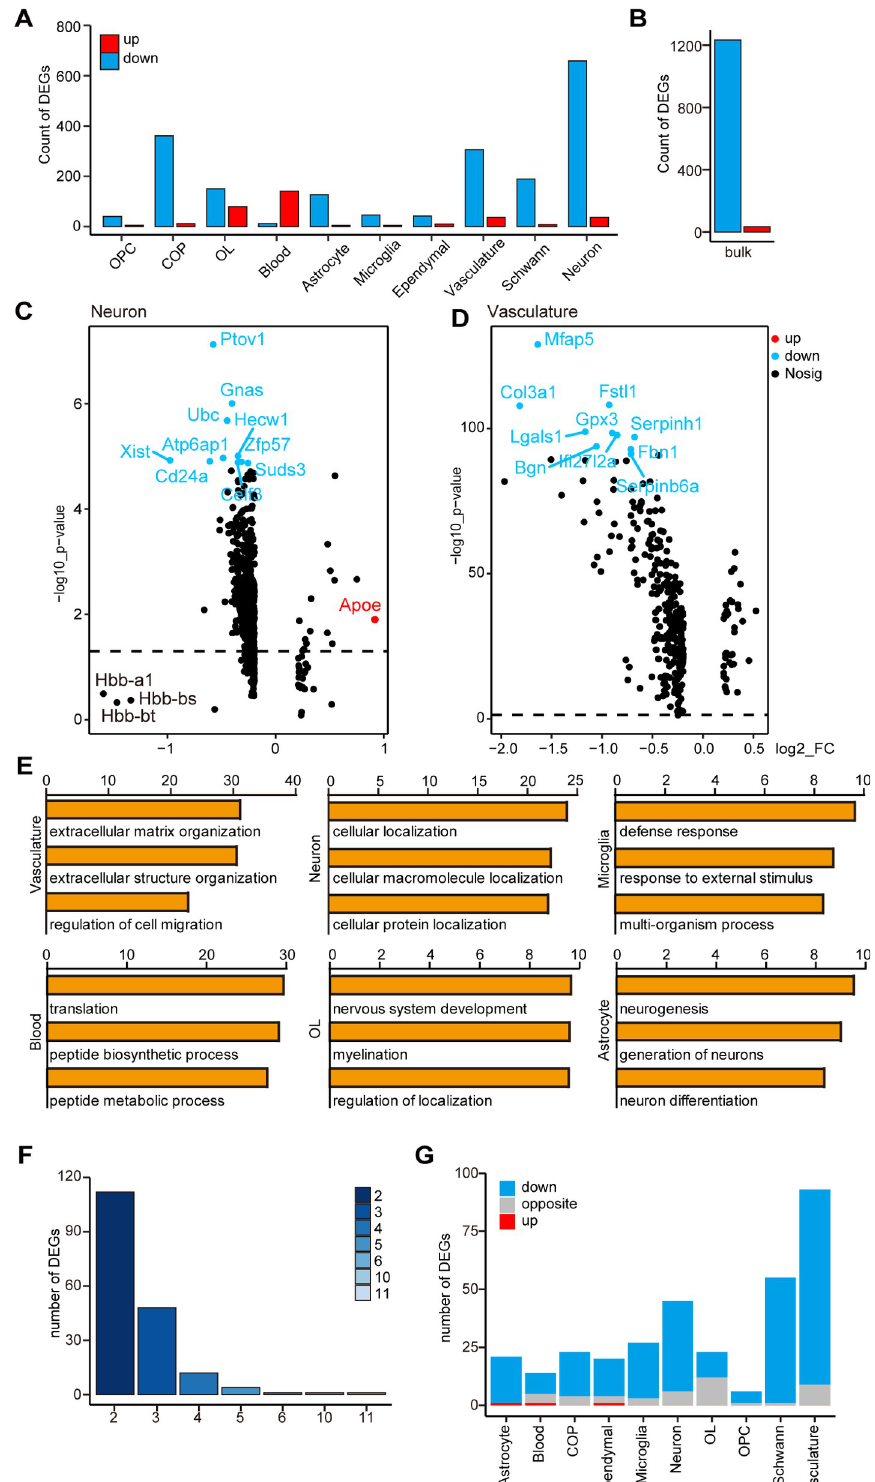
Fig 2. Analysis of DEGs and functions of scRNA-seq and bulk-seq. (A) The number of DEGs in different cell types in scRNA-seq. (B) Number of DEGs in bulk-seq. (C) A volcano plot showing DEGs in neurons. (D) Volcano plot showing DEGs of the vasculature. The x-axis represents logFC, and the y-axis represents log10 p-value. (E) GO